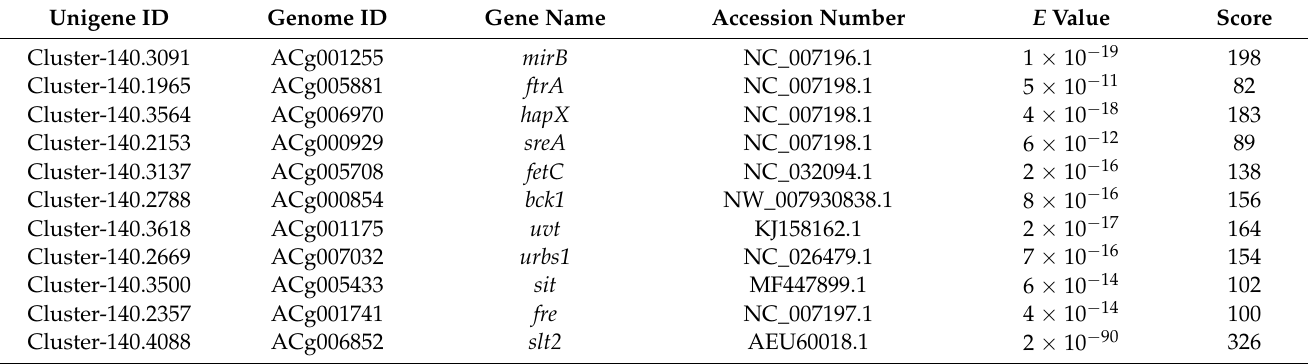
Table 2. Genes that may be related to the Fe 2+ -mediated asexual sporulation of A. cinnamomea among DEGs. Unigene ID Genome